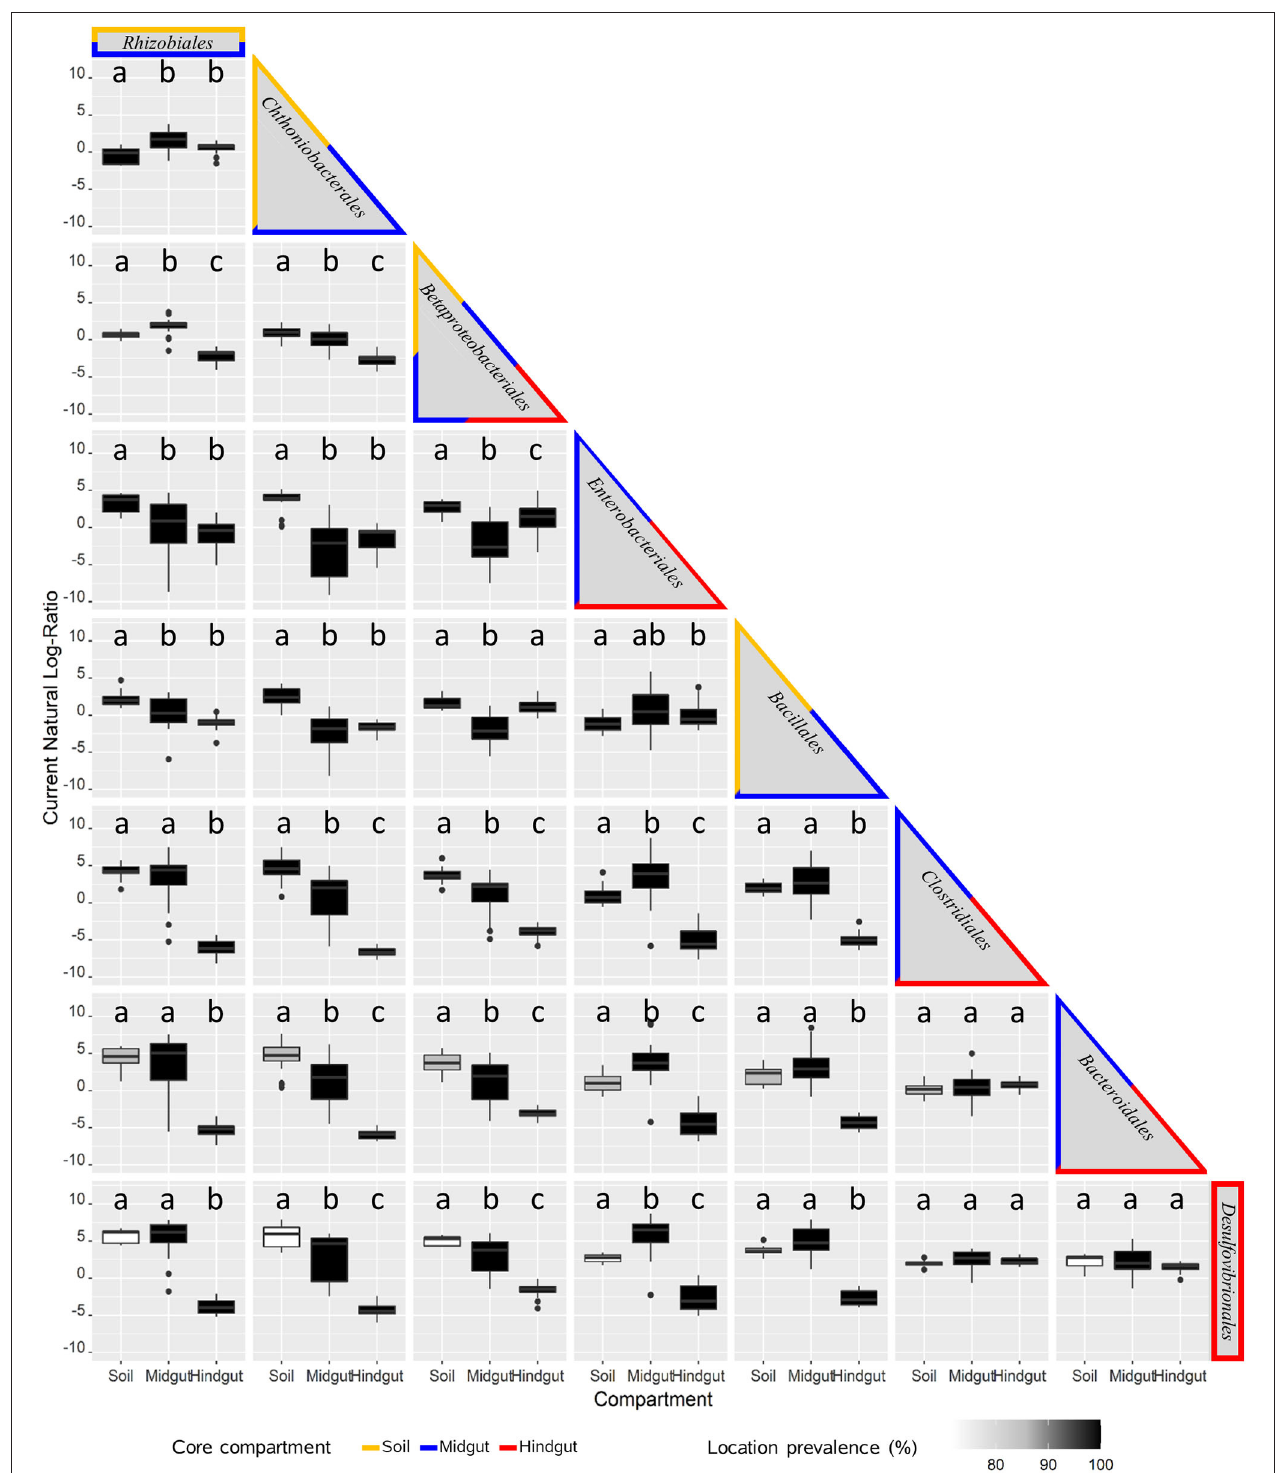
FIGURE 5 | Pairwise analysis of key prokaryotic taxa variation across compartments: midgut and hindgut from third instar larvae of the Japanese beetle ( P. japonica ), and associated soil. The natural log-ratio of taxa for each sample was calculated using qurro (Fedarko et al., 2020), with taxa in columns as numerators, and the ones in rows as denominators. Taxa are presented in order of criteria for consideration ( Supplementary Table 6 ), including the most prevalent and/or top taxa driving most of the difference among compartments. The border color identifies the presence of taxa in the core microbiota of the compartment for soil, midgut, and hindgut. The presence of taxa in locations (location prevalence %, n = 7) is represented by the color of the boxplot. Compartments with different lowercase letters indicate a significant difference at α = 0.05, Brown-Forsythe Test with Bonferroni correction.